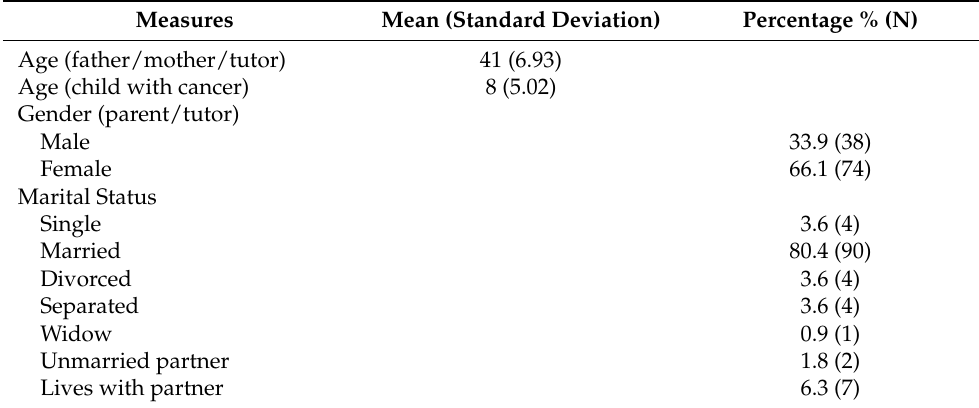
Table 1. Demographic and clinical data ( n =